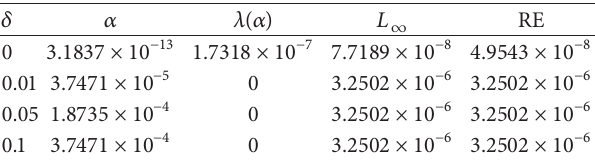
Table 2: 𝑇 = 0.5 , the objective function 𝜆(𝛼) , the 𝐿 ∞ , and the relative errors for 𝑓(𝑥) , with 𝛿 = 0,0.01, 0.05, 0.1 .